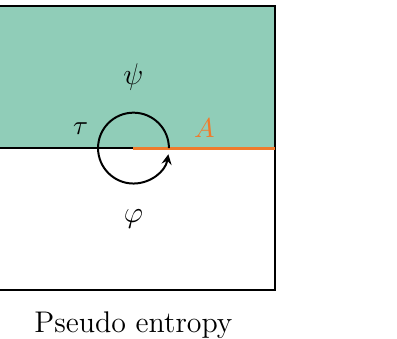
Figure 18 . The replica partition function for the interface entropy.